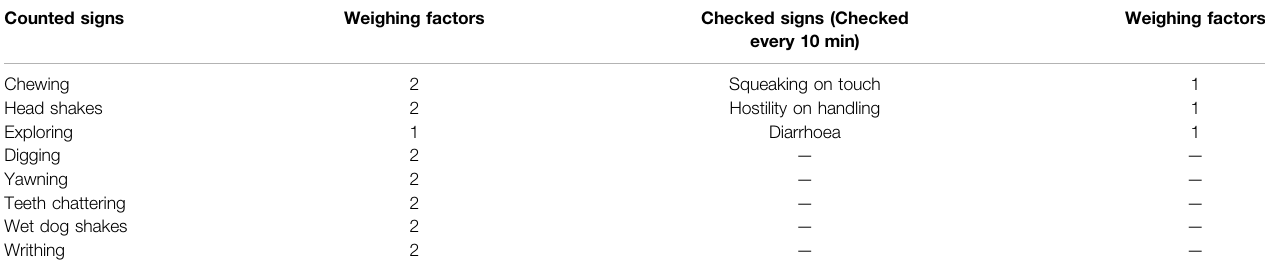
TABLE 1 | The counted signs and checked signs with the respective weighing factors for the evaluation of mitragynine-withdrawal severity in rats. Counted